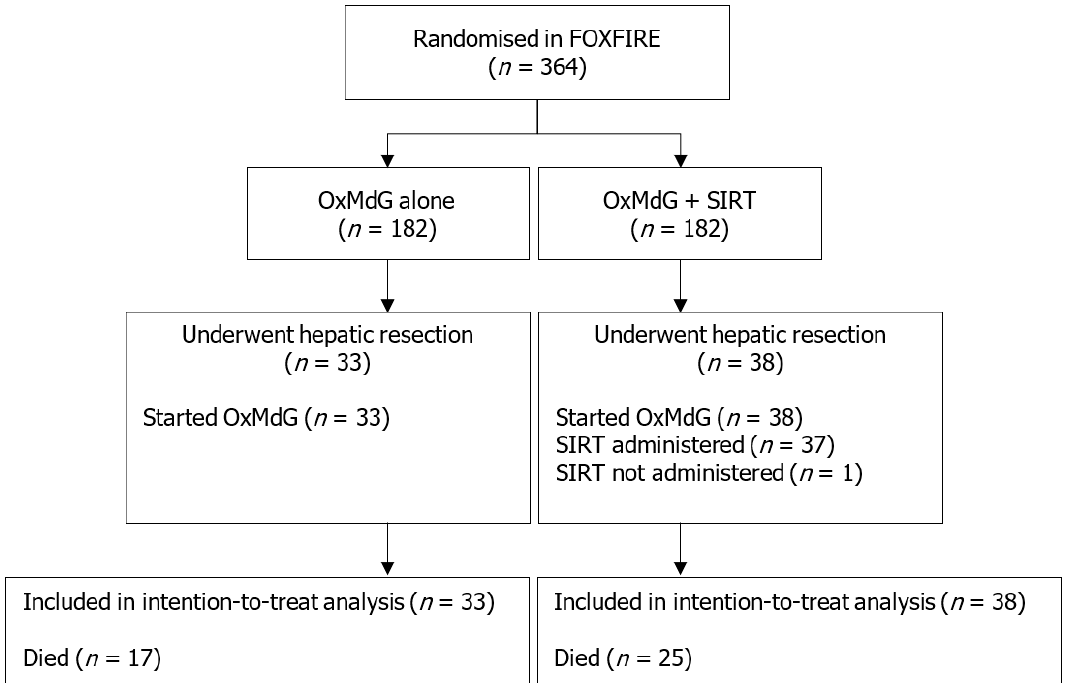
Figure 2. Study flow chart. OxMdG: Oxaliplatin, 5-fluorouracil and folic acid. SIRT: Selective internal radiotherapy. One patient in the OxMdG + SIRT group who underwent hepatic resection had started OxMdG chemotherapy, but did not receive SIRT.